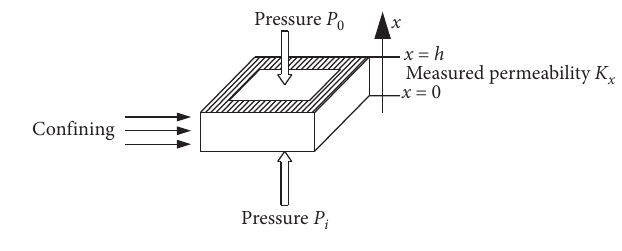
Figure 4: Boundary